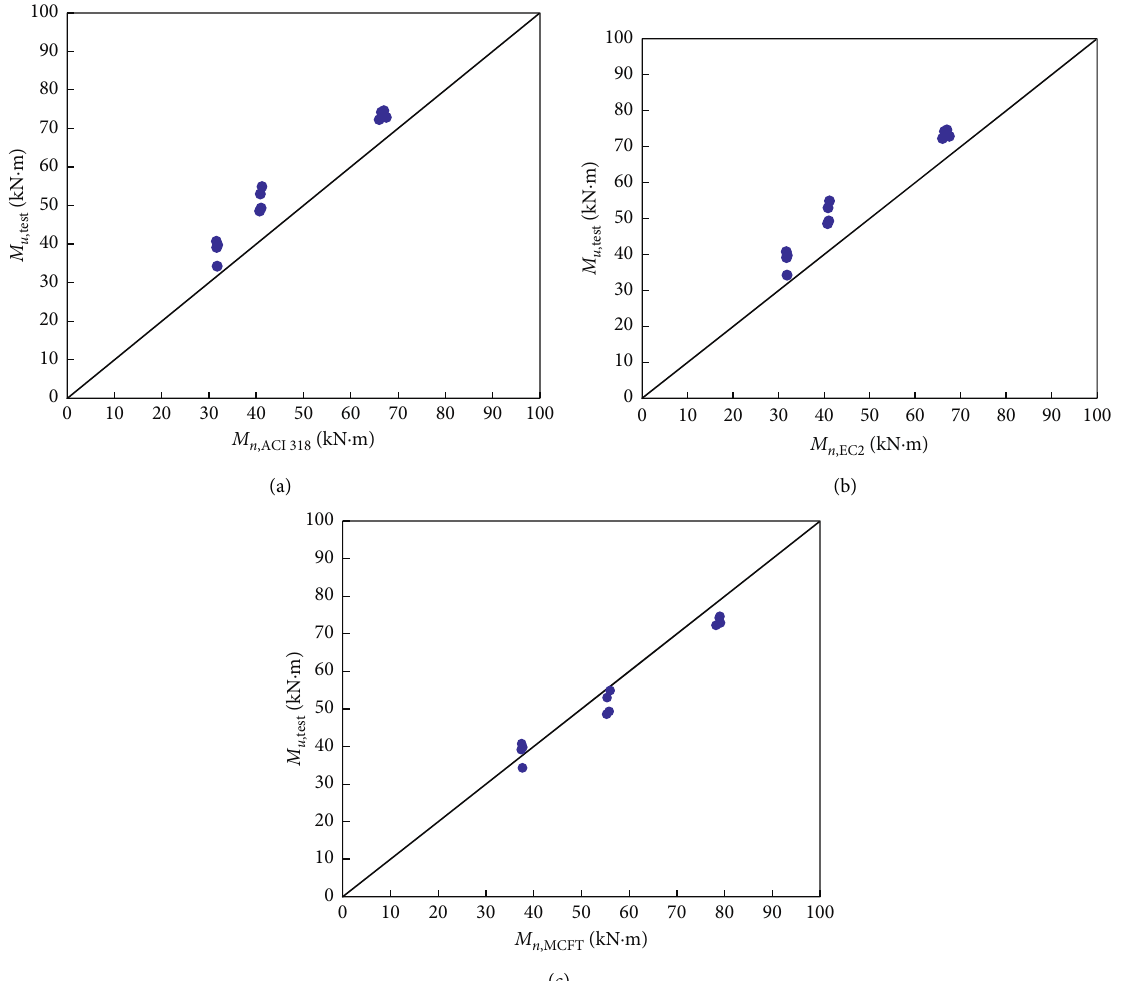
Figure 12: Comparison of flexural strength values. (a) ACI 318 provision. (b) EC 2 provision. (c) MCFT